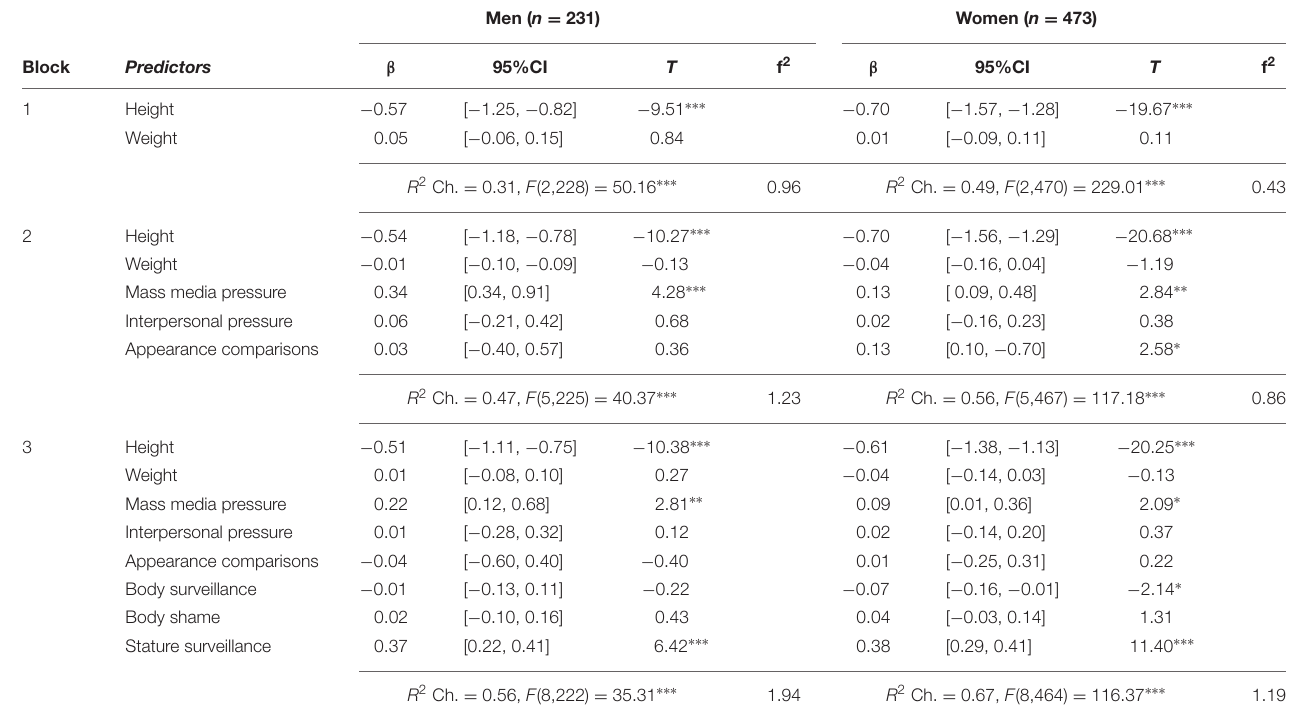
TABLE 3 | Predictors of stature concerns among young adult Chinese women and